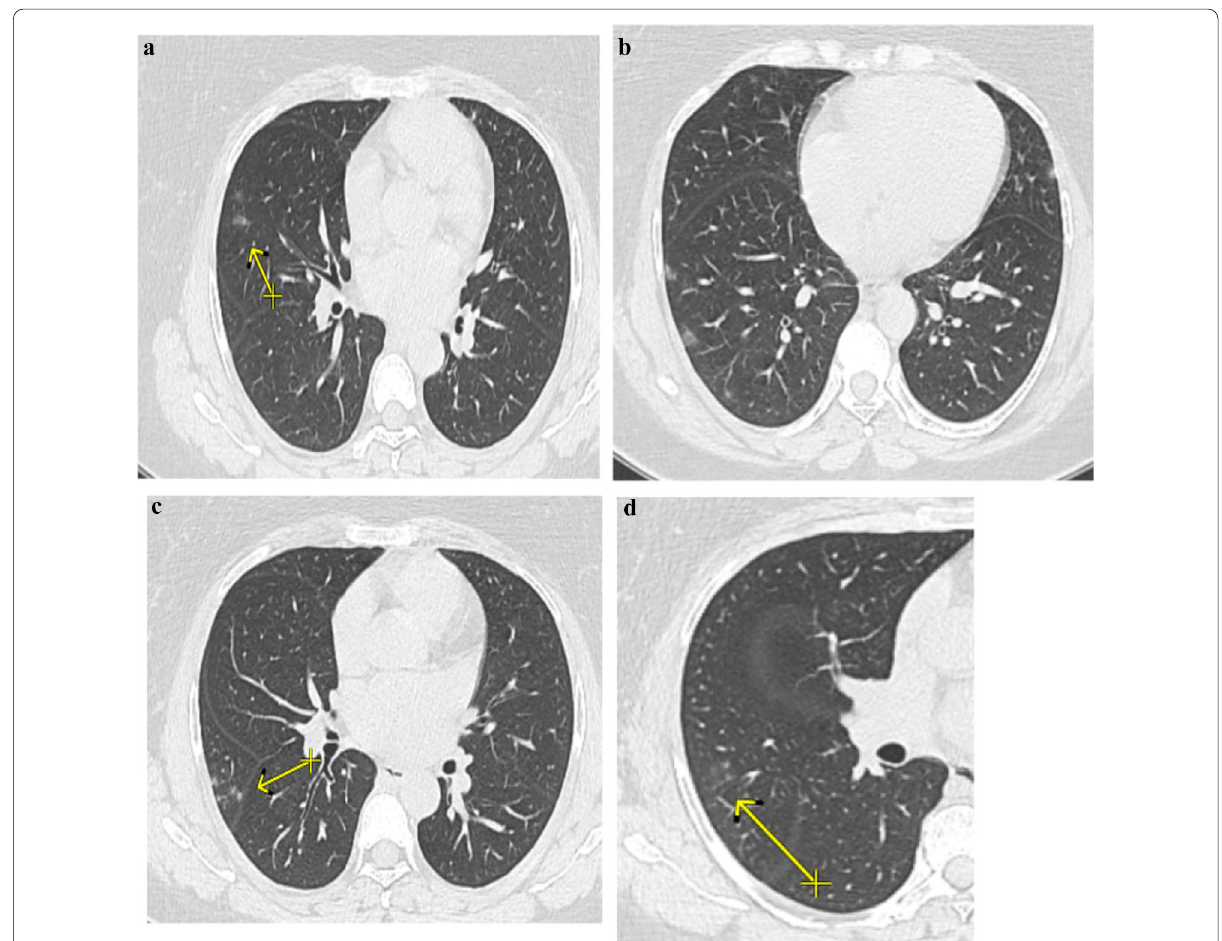
Fig. 5. A 33-year-old male presented with anosmia, loss of taste, fever, diarrhea and myalgia at July 2020 and positive PCR for COVID 19 infection, a and b noncontrast CT axial cuts shows bilateral faint ground glass opacities. The patient diagnosed as COVID 19 infection with CT score severity: 6. Second infection dated June 2021 the patient presented with anosmia with positive PCR test for COVID 19 infection. c and d noncontrast CT chest images show right lower lobar patchy subpleural faint ground glass opacities. The patient diagnosed as COVID 19 re-infection with CT severity score: 2